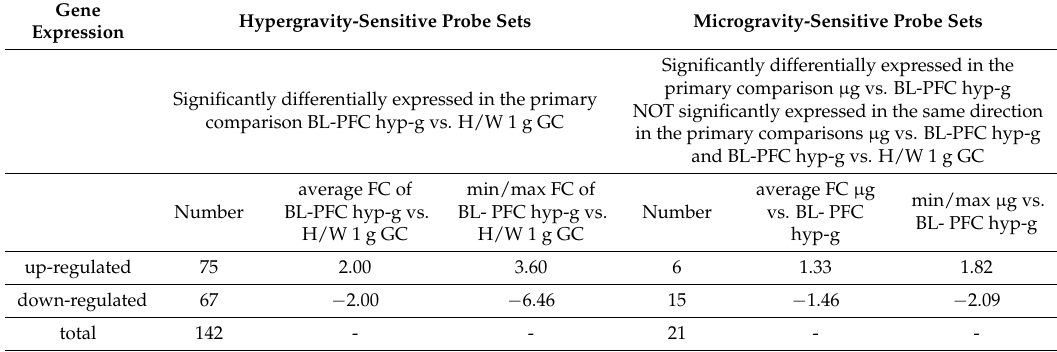
Table 8. Definition and numbers of hypergravity- and microgravity-sensitive probe sets that are differentially expressed in response to hypergravity or microgravity in human U937 monocytic cells during parabolic